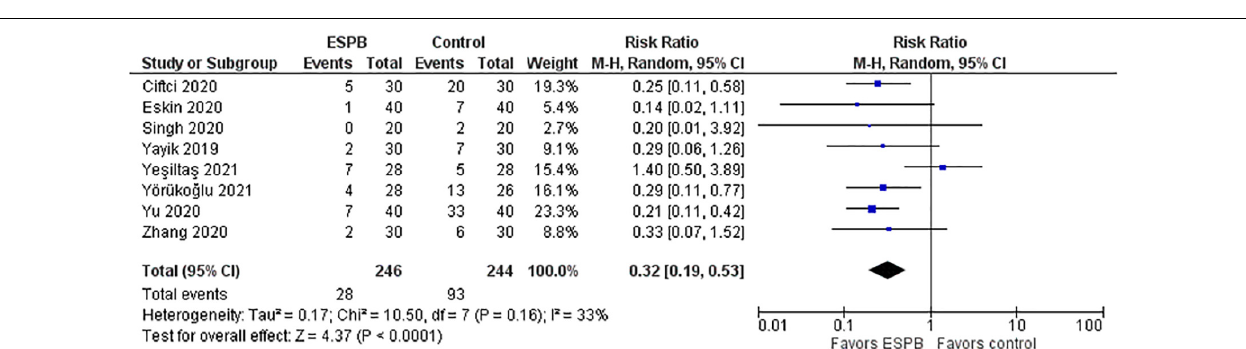
FIGURE 4 | Pain intensity during movement measured 24 h after surgery.